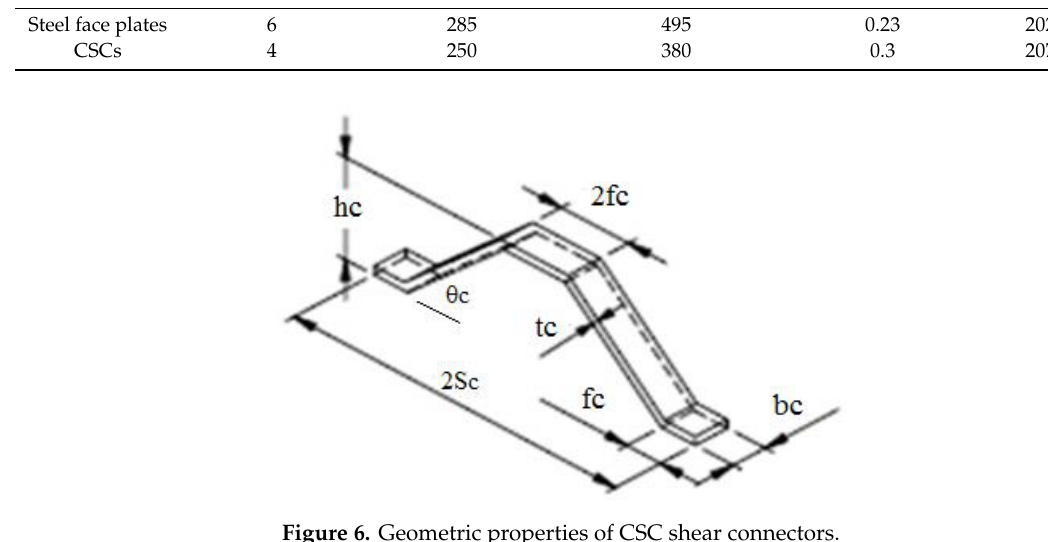
Figure 6. Geometric properties of CSC shear connectors. Table 6. Dimensional properties of CSC shear connectors.